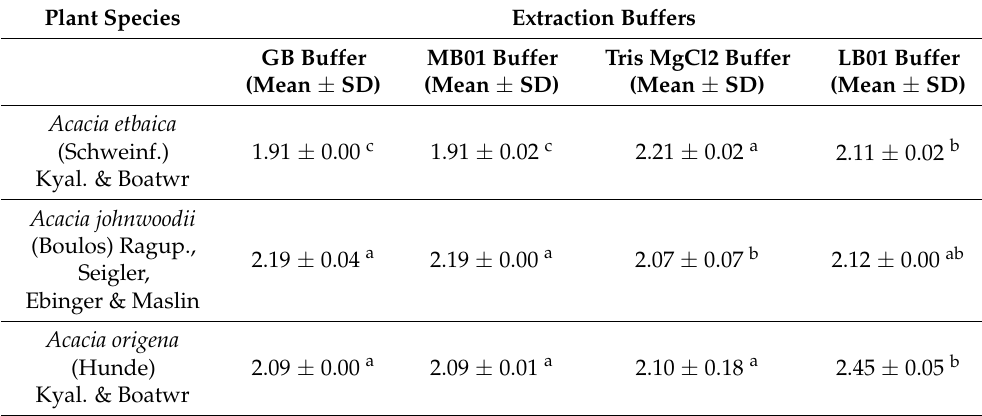
Table 2. Genome size (2C DNA content) of Acacia species as nuclei isolated with different nuclei extraction buffers with slight modification (0.6% β -mercaptoethanol and 2% PVP). Plant Species Extraction Buffers GB Buffer MB01 Buffer Tris MgCl2 (Mean ± SD) (Mean ± SD)